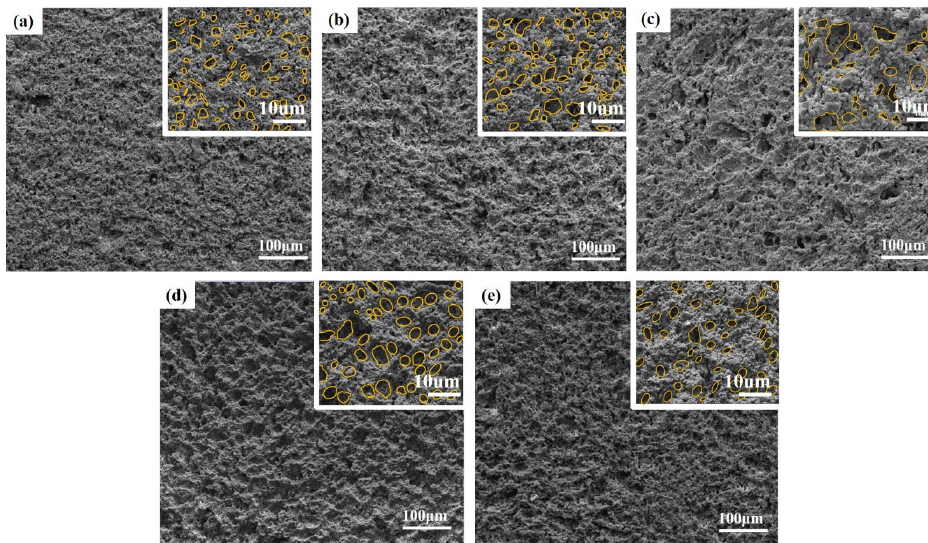
Fig. 1 SEM micrographs of specimens: (a) C220, (b) C330, (c) C774, (d) C330-774, and (e)